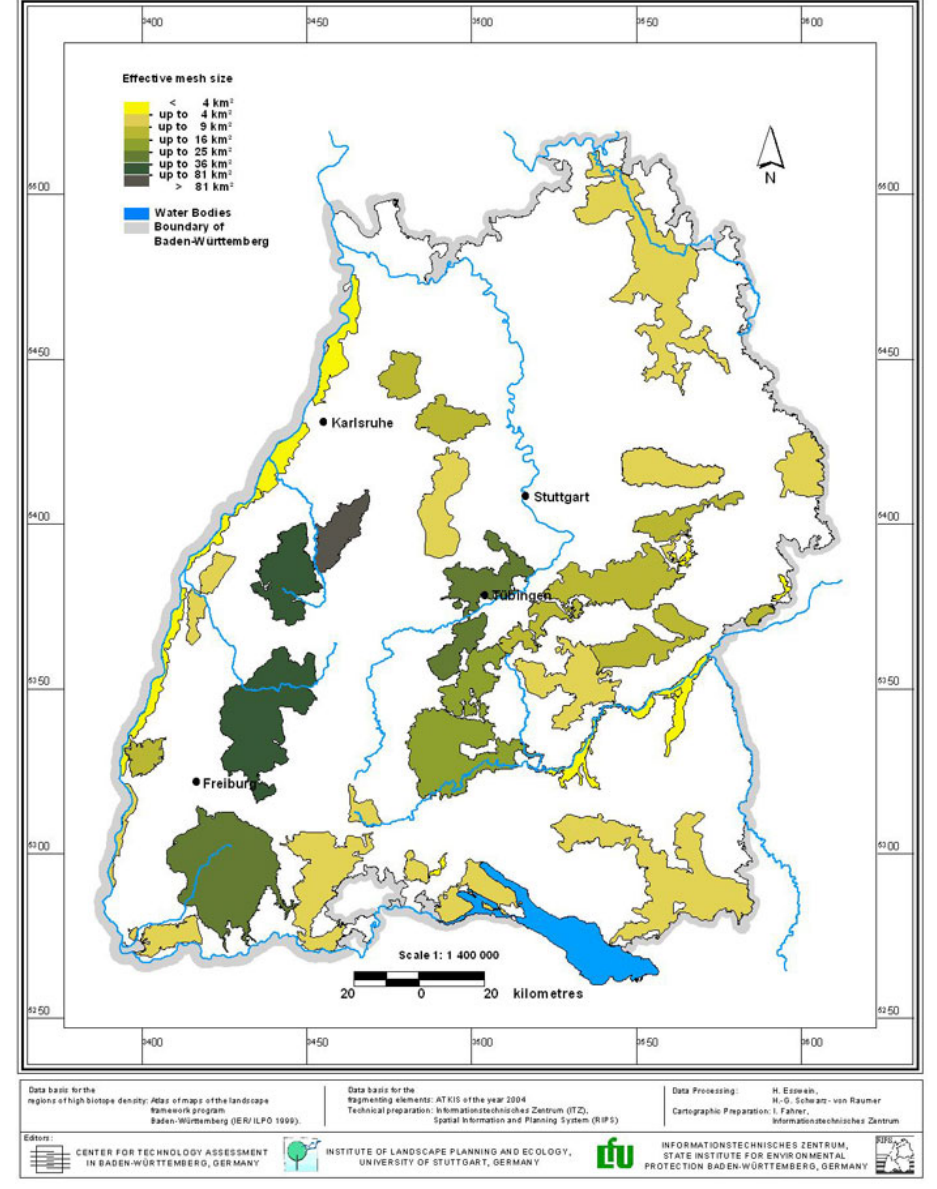
Fig. 9. Current (2004) degree of landscape fragmentation of the regions with high biotope density in Baden-Württemberg (fragmentation level including municipal roads) in terms of the effective mesh size ( m ; in km²). (Click here to view or download a high resolution pdf version. File size: 288 eff